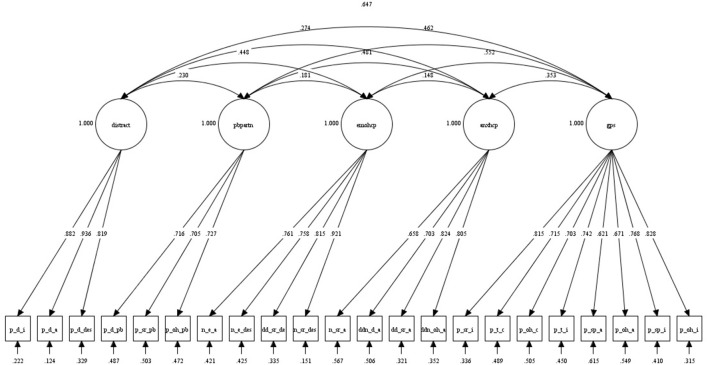
Five-factor model derived from CFA in N = 120 individuals with musculoskeletal pain (Study 3). The figure shows completely standardized estimates which, if squared, correspond to percentage variance in observed measure accounted for by the latent factor. “gps” denotes General Partner Support, “anxhcp” Anxiety in Context of HCPs, “emohcp” Emotional Support from HCPs, “pbpartn” Pain Behaviors in Context of Partner, and “distract” denotes the Distraction by Partner factor. Indicator abbreviations are explained in Table 2.